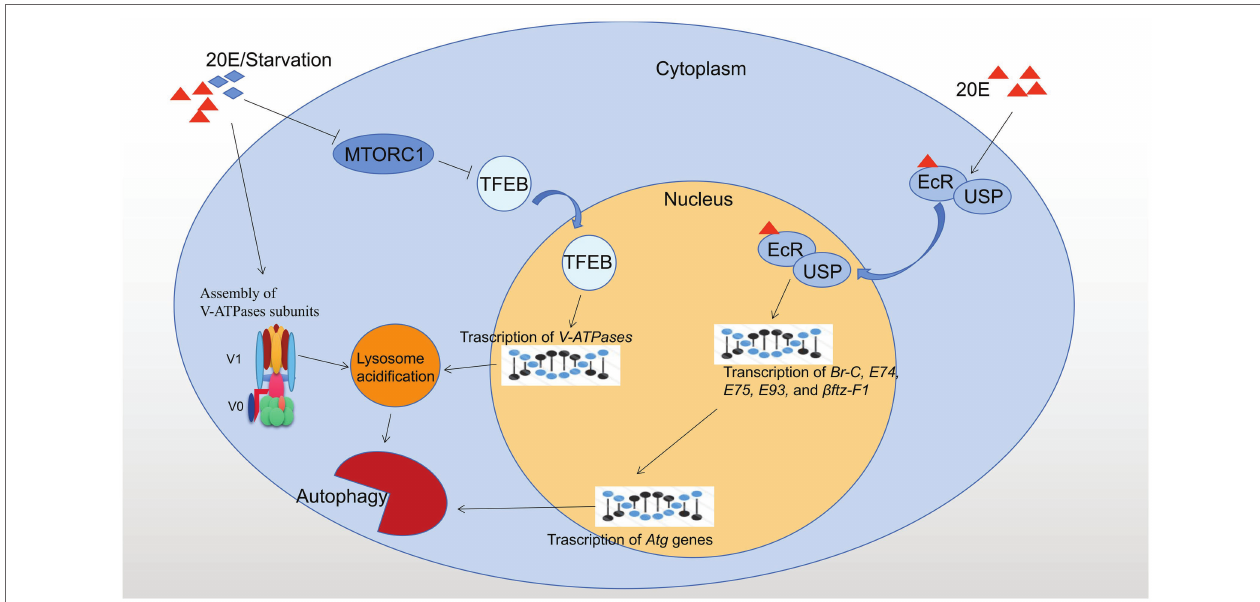
FIGURE 1 | Transcriptional regulation of autophagy by 20E and starvation in B. mori and D. melanogaster . 20E and starvation both result in the cytoplasmic-nucleo translocation of TFEB by inhibiting MTORC1 activity and promote the assembly of V-ATPase subunits. Consequently, nuclear-localized TFEB promotes the transcription of V-ATPases , and thus upregulation of lysosomal acidification and autophagic flux. 20E forms a ligand-receptor complex with the heterodimer EcR/ USP and then is transferred into the nucleus to initiate the expression of the downstream transcription factors, such as Br-C, E74, E75, E93, and β ftz-F1 , which subsequently leads to upregulation of Atg genes and autophagy. Red triangles indicate 20E; blue rhombuses indicate